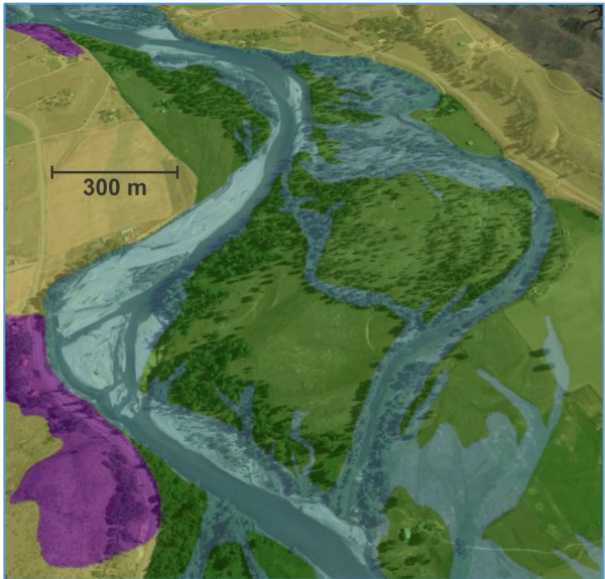
Figure 5. Oblique upstream view of the Methow River (river mile 34.25–35.75). Flow is from the upper left to the bottom right of the images; base imagery from Google Earth. Lack of levees and other bank armoring has allowed the river to occupy multiple channels over the past century, giving rise to a physically diverse and ecologically-rich suite of riverine habitats. Overlaid colors indicate geologic material, the relative age, and elevation of the floodplain and adjacent surfaces: purple = bedrock, blue = modern or recently-active channel (within 1 m of modern low-water surface elevation); green = prior floodplain surface (within 1–4 m of modern low-water surface elevation), tan/gray = higher terraces (mostly of glacial origin).